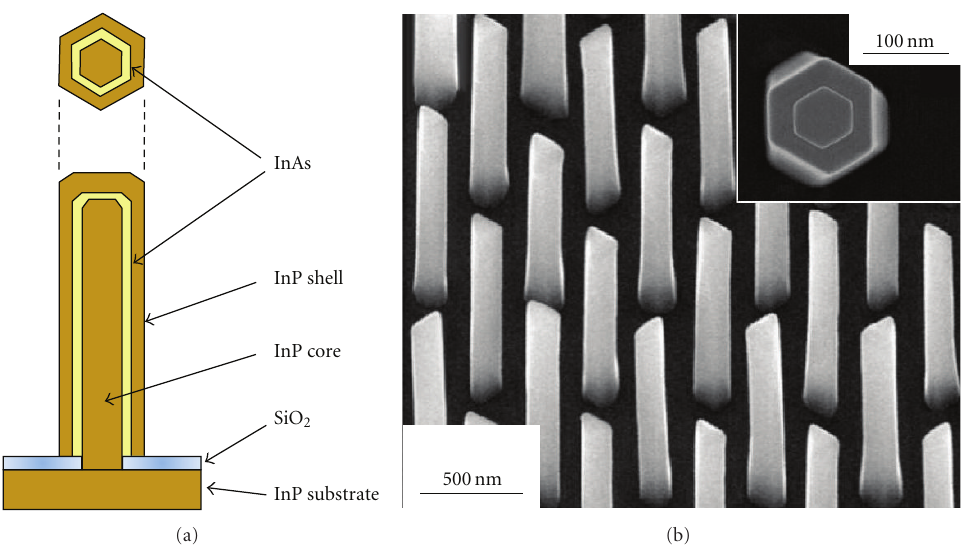
Figure 20: Cross-sectional structures and SEM images of nanowires. (a) Schematic of cross-sections of InP/InAs/InP core-multishell nanowire. (b) SEM image of periodically aligned InP/InAs/InP core-multishell nanowire array. Inset is top view of high-resolution SEM image of core-multishell nanowire observed after anisotropic dry etching and stain etching [31].